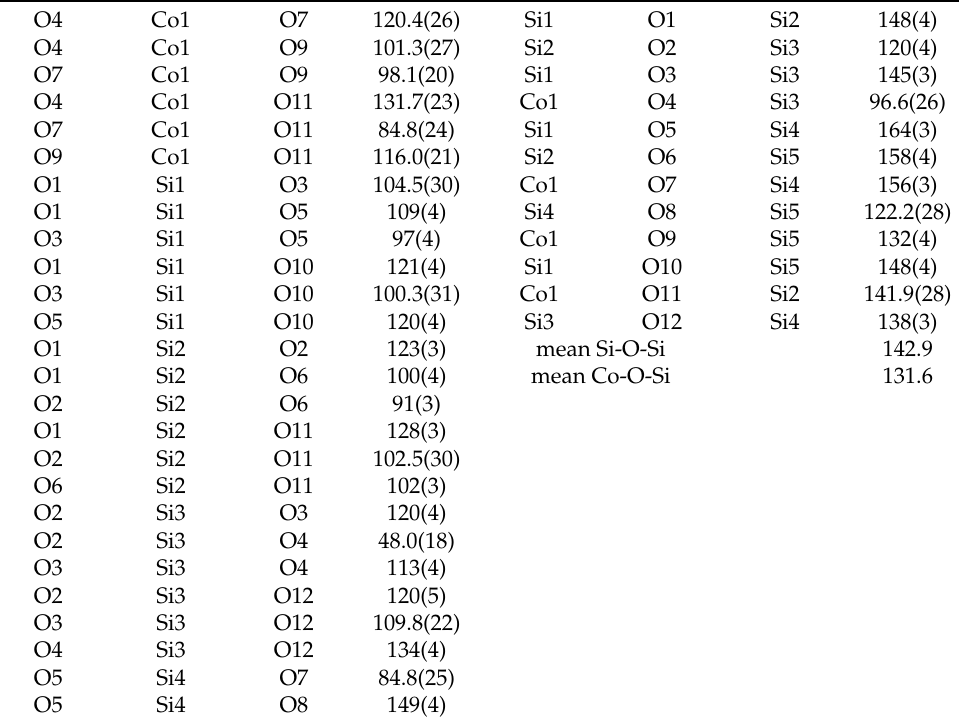
Table 3. Refined interatomic angles ( ◦ ) for ambient temperature Rb 2 CoSi 5 O l2